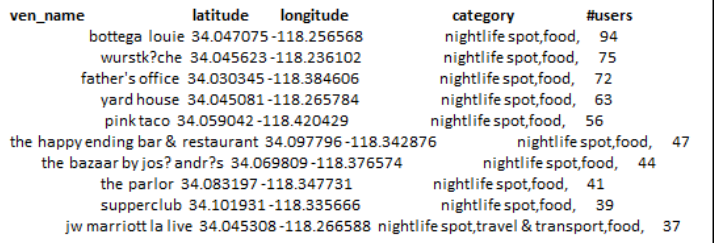
Figure 10. Top-10 influential locations in Log Angles using t-RF algorithm.